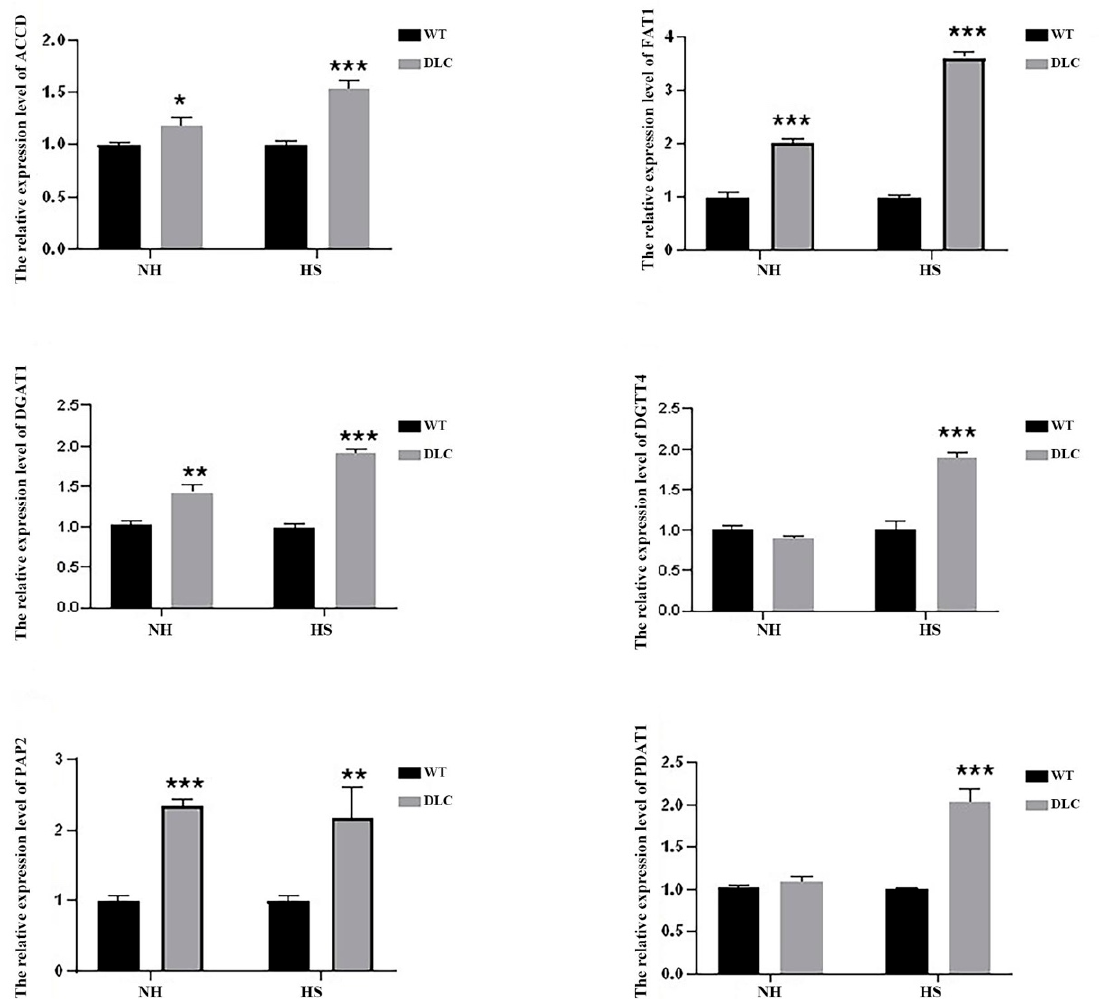
Figure 6. The qRT-PCR analysis of the expression levels of key genes involved in lipid metabolism in the DLC-4 and WT when strains were treated with HS (HS) and without HS (NH). Statistical significance (one-way ANOVA) is represented by asterisks (*, **, and *** indicate a difference at p ≤ 0.05, p ≤ 0.01, and p ≤ 0.005, respectively). Error bars depict SD.